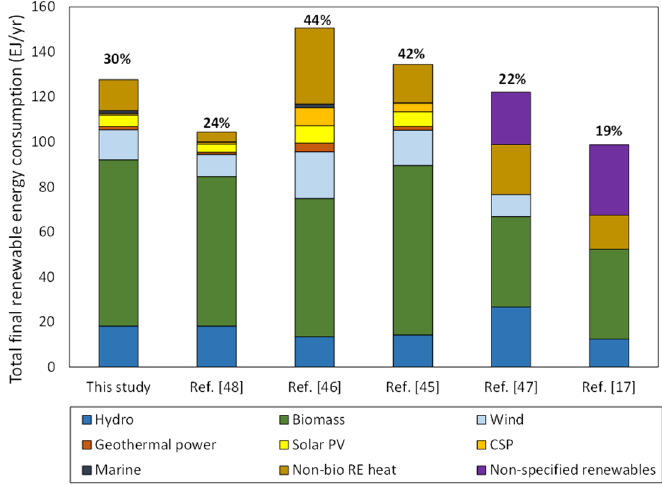
Figure 6. Comparison of REmap 2030 results with literature